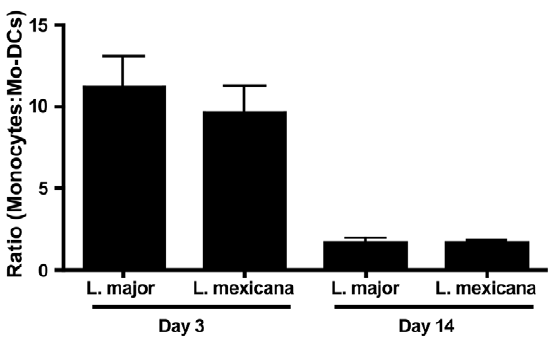
Figure 2. L. mexicana infection does not lead to a defect in differentiation of monocytes to mo-DCs. C57BL/6 mice were infected in the ear with L. major or L. mexicana and ears were processed as above. Percentage of monocytes and mo-DCs on day 3 and 14 were used to determine a ratio of differentiation from monocytes to mo-DCs in L. major or L. mexicana infected mice. The results expressed are the mean ratio ( 6 SE) of 3 mice per group. The results are representative of two experiments.